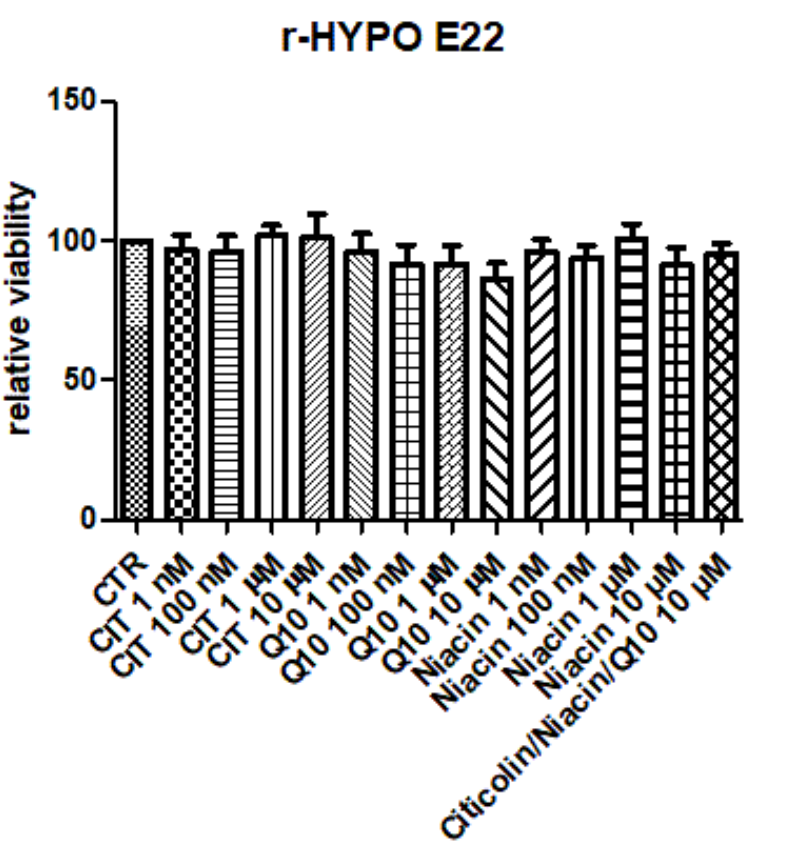
Figure 1. Null effect of citicoline, niacin (vitamin B3), coenzyme Q10 (1 nM–10 µM), and their fixed combination (10 µM) on hypothalamic HypoE22 viability. The cell viability was measured via MTT test. The null effects induced by single ingredients and their association indicated a complete biocompatibility in the selected in vitro model.